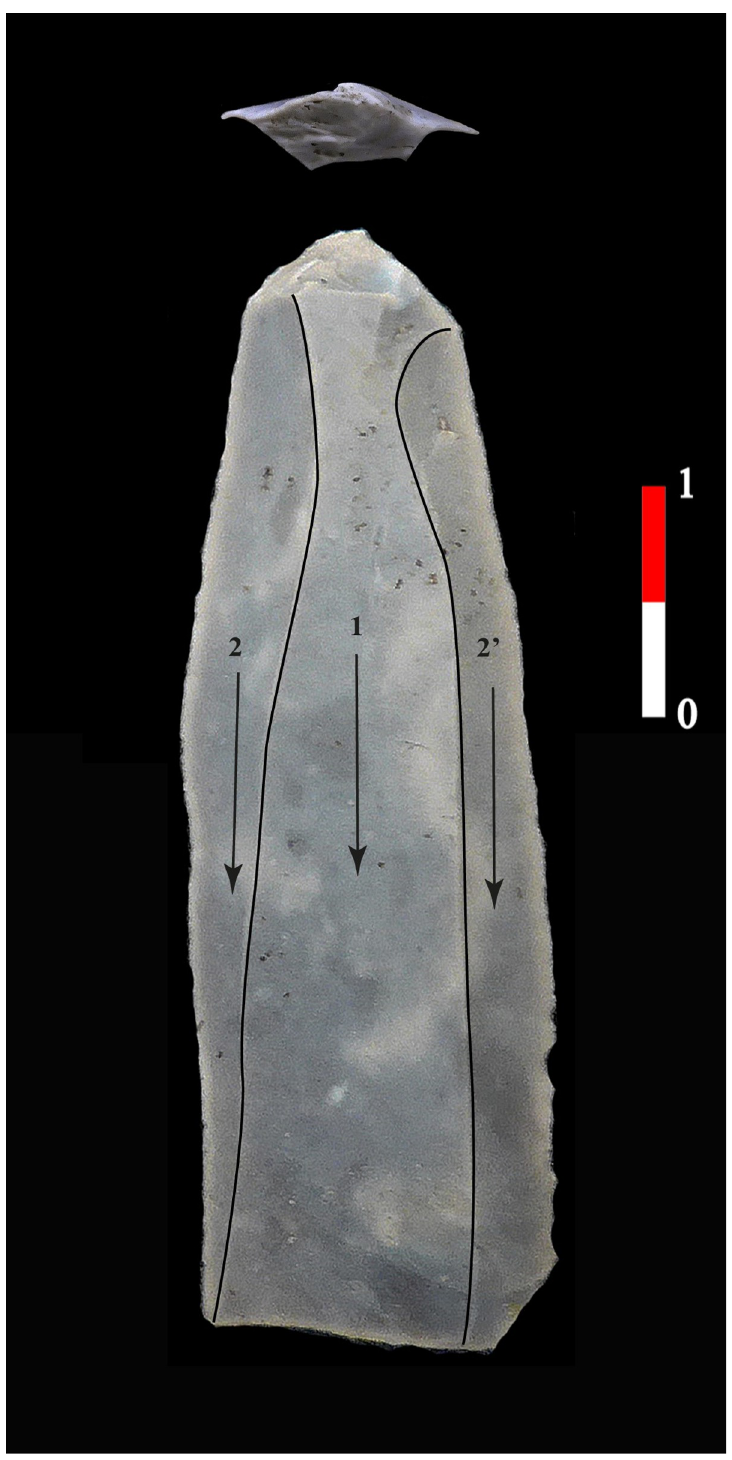
Fig 11. Blade of Cretaceous flint in the House 120 of Bucy-le-Long “La He´ronni è re”. Blade of group 1 where abrasion is intensive, resulting in a significant narrowing of the striking platform and creating narrow, linear, or sometimes filiform butts, (BLH, 122–81, Soissons, France).